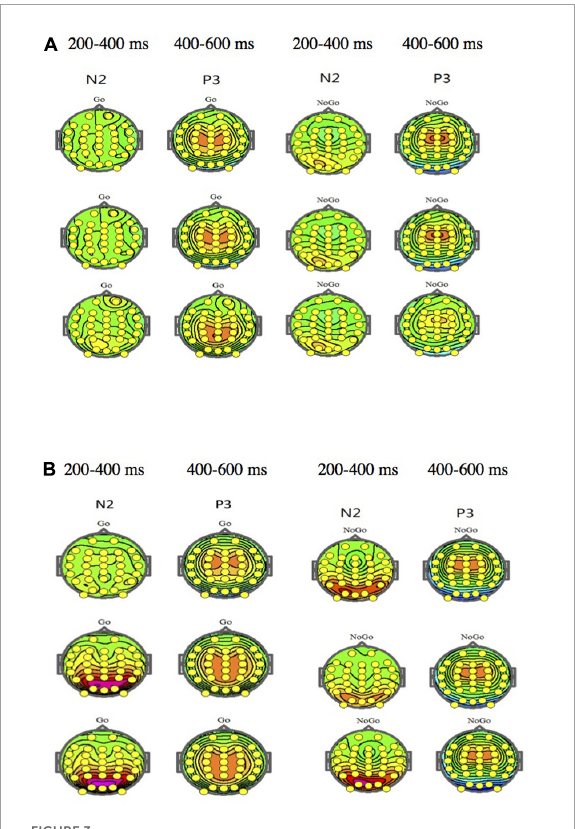
(A) The topographical map of the high self-efficacy group. (B) The topographical map of the low self-efficacy